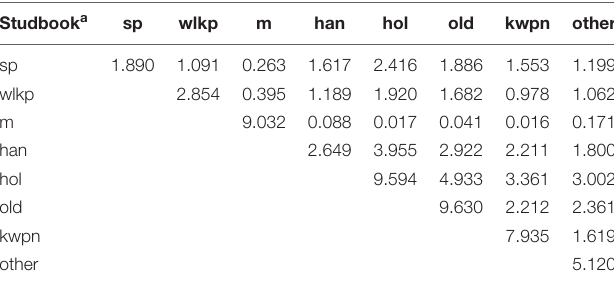
TABLE 7 | Average numerator relationships (%) within breed groups (diagonal) and between breed groups (above diagonal). Studbook a